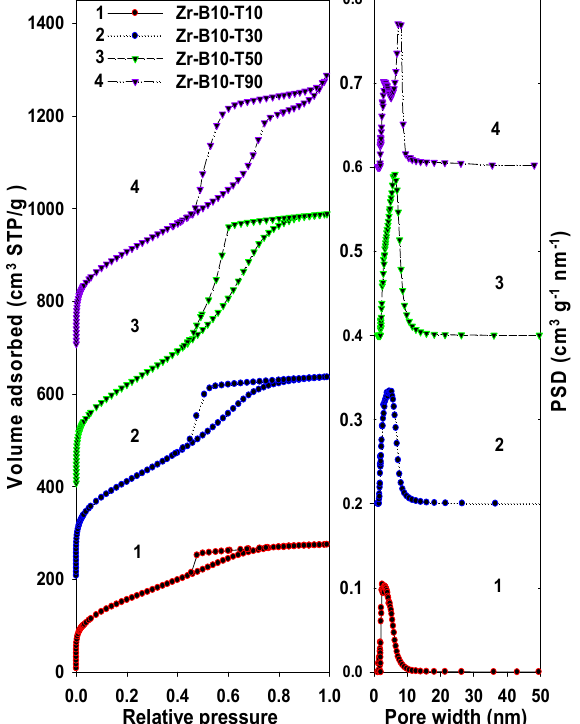
0.0 Relative pressure Figure 3. N 2 ‐ adsorption isotherms ( left panel ) and corresponding PSD curves ( right panel ), for Zr ‐ B10 ‐ TX samples; isotherms 2, 3, and 4 are shifted by 200 cm 3 STP/g, 400 cm 3 STP/g, and 700 cm 3 STP/g, in relation to isotherm 1, respectively. PSD curves are shifted by a multiple of 0.2 cm 3 g − 1 nm − 1 . For Zr ‐ B10 ‐ T50/Zr ‐ I10 ‐ T50 and Zr ‐ B10 ‐ T90/Zr ‐ I10 ‐ T90 samples, desorption steps start at the relative pressure of ~0.64 and finish, suddenly, at a relative pressure of about 0.42, as compared to the other samples studied. N 2 ‐ adsorption isotherms shown in Fig ‐ ures 2 and 3 (left panel) were used to evaluate the surface properties, including the specific ‐ surface area, pore volume (fine pores < 3 nm) and single ‐ point ‐ pore volume, primary ‐ mesopore volume, and diameter (see Table 1). Note that the gradual increase in the amount of TEOS in the initial ‐ reaction mixture enhances the cross ‐ linking between siloxane bonds. It, also, reduces the structural collapse and, subsequently, enlarges the specific ‐ surface area, pore volume, and pore diameter. For instance, the Zr ‐ I10 ‐ T10 sample exhibits surface area, single ‐ point ‐ pore volume, and pore width of 528 m 2 /g, 0.51 cm 3 /g, and 3.9 nm, respectively, and these values increase to 743 m 2 /g, 0.81 cm 3 /g, and 6.6 nm for Zr ‐ I10 ‐ T90. Samples thermally treated at 600 °C (Zr ‐ I10 ‐ TX* and Zr ‐ B10 ‐ TX* (X = 10, 30, 50, and 90)) did not show a significant change in the shape of isotherms and their PSD curves, compared to the respective samples thermally treated at 350 °C (compare the plots shown in Figures 2–5). Nevertheless, the samples thermally treated at 600 °C show a slight decrease in the structural parameters, as compared to the similar samples thermally treated at 350 °C (see Table 1). For instance, the Zr ‐ I10 ‐ T50 sample exhibits surface area and pore width of 739 m 2 /g and 6.1 nm at 350 °C, respectively, and these values decrease to 657 m 2 /g and 5.4 nm, respectively, upon thermal treatment at 600 °C. Similarly, surface area and pore width of the Zr ‐ B10 ‐ T50 sample decrease from 809 m 2 /g to 604 m 2 /g and 6.3 nm to 5.8 nm, respectively, as the temperature increases from 350 °C to 600 °C (see Table 1).